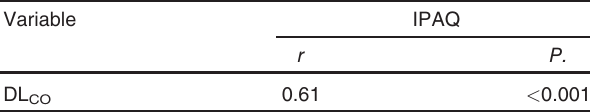
Table 9 Validity of Saint George Respiratory Questionnaire versus diffusion lung capacity for carbon monoxide